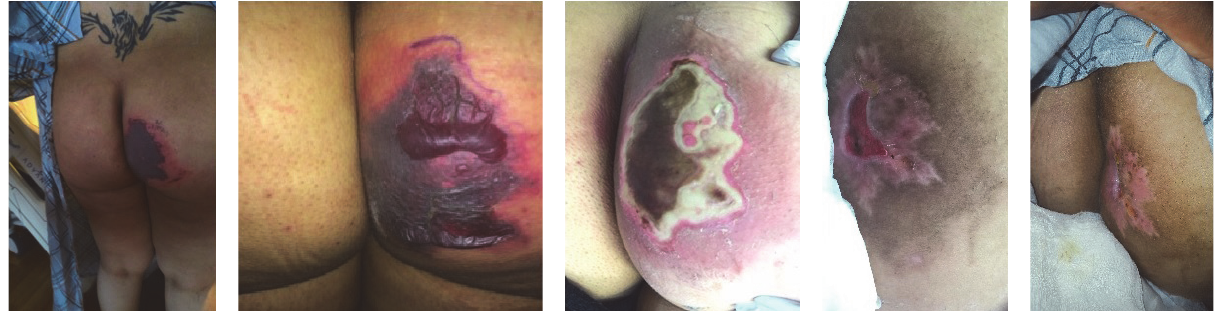
Figure 3: Buttock lesion images demonstrating progression and healing. From left to right: postoperative day one, day three, week four, week eight, and week